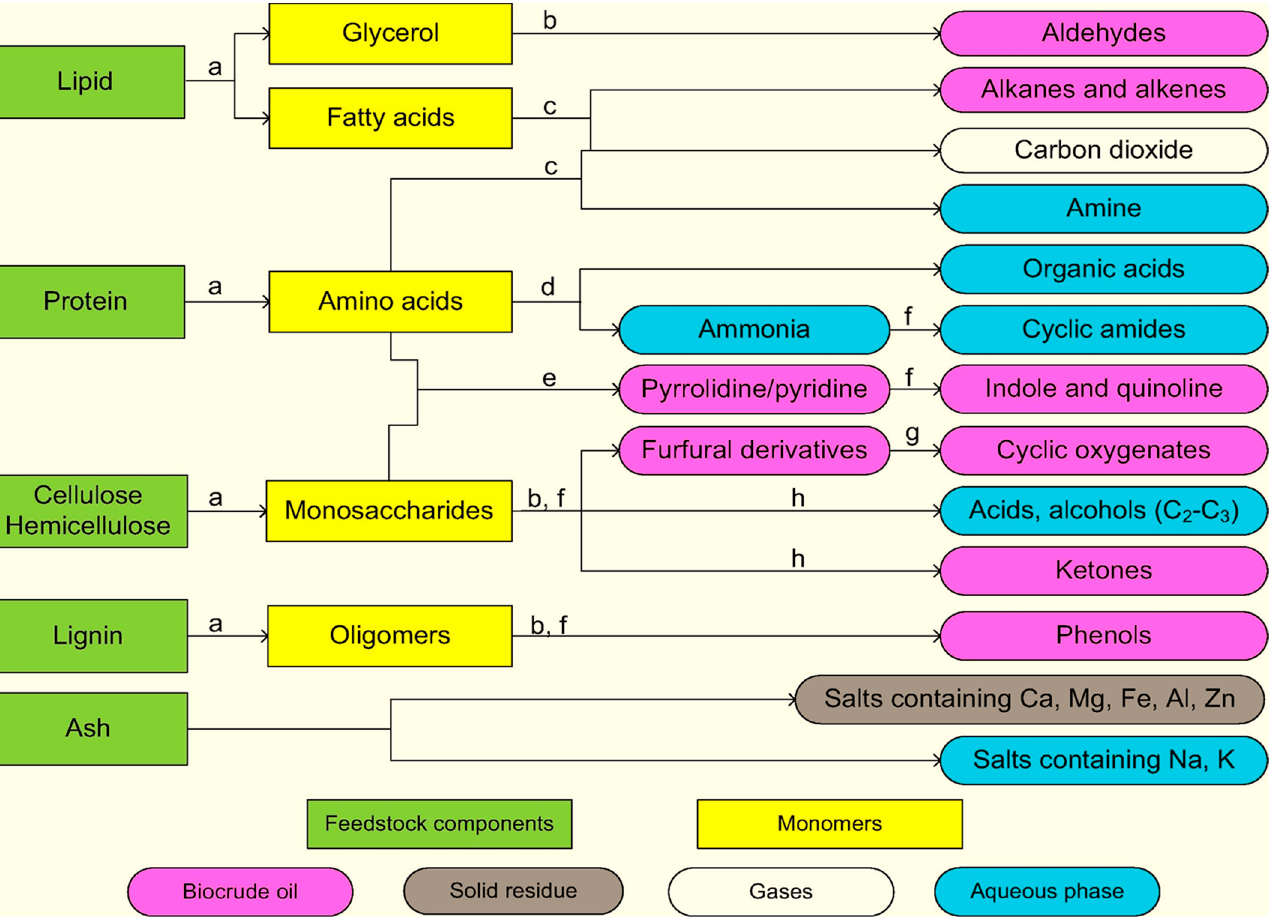
Figure 8. Proposed reaction pathways involved in the hydrothermal conversion of waste materials, such as human feces to biocrude and value-added chemicals. Adapted from Lu et al. [69]. (( a ) hydrolysis; ( b ) dehydration; ( c ) decarboxylation; ( d ) deamination; ( e ) Maillard reaction; ( f ) cyclization; ( g ) polymerization; ( h ) decomposition).